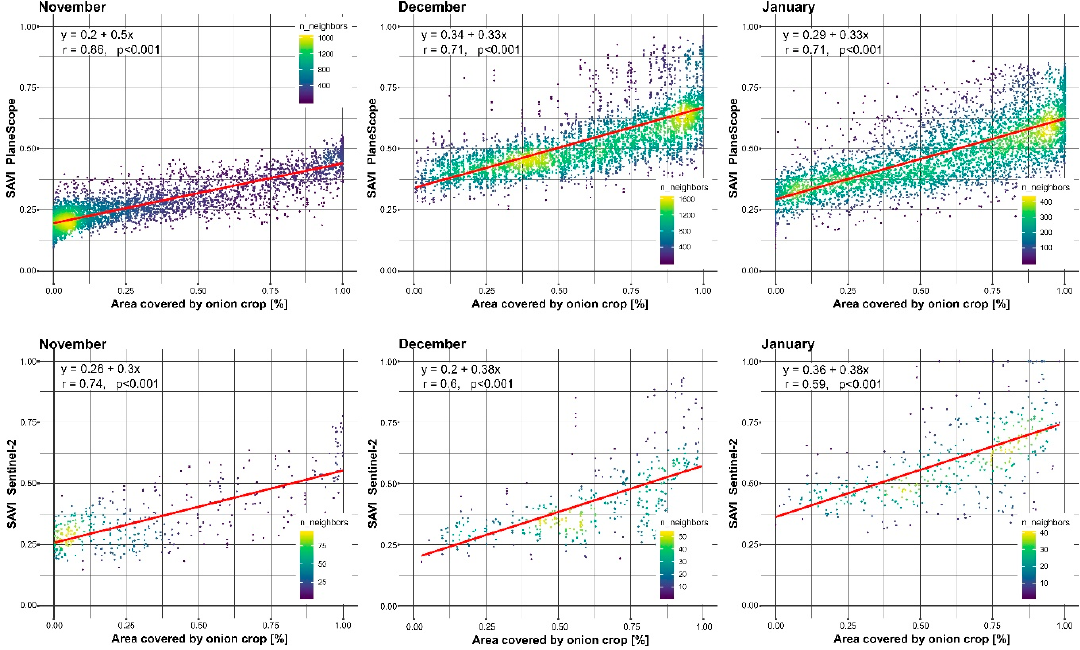
Figure 10. Scatter plots, showing the correlation between SAVI values from satellites and the area covered by onion crop (x-axis) in the three months